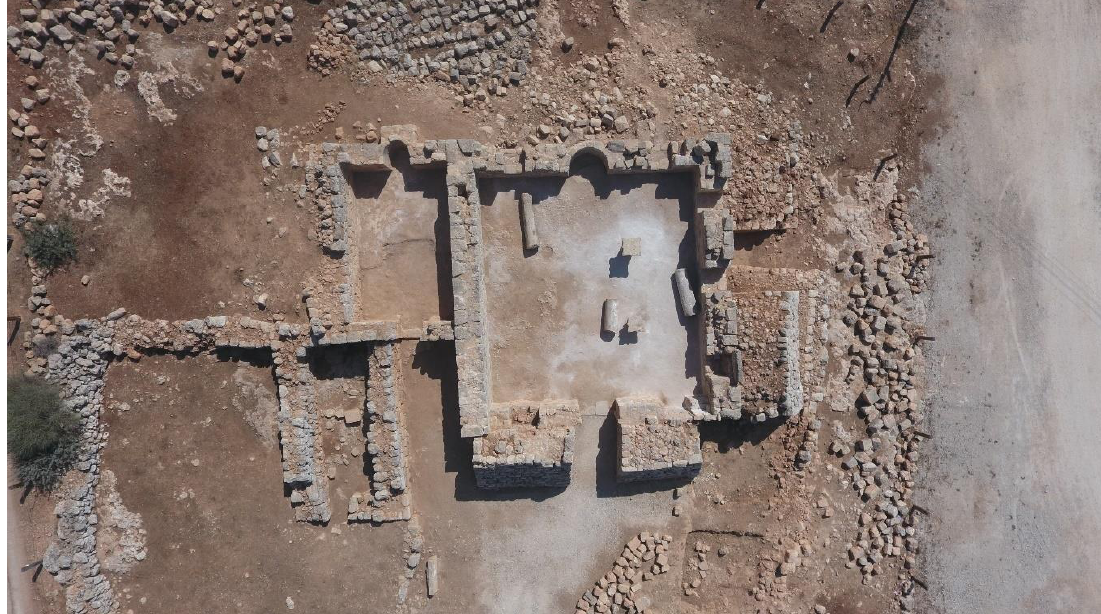
Figure 2. Jami ʿ al-Sitin : South to the top, courtesy of https://www.a-shiloh.co.il/en (accessed on 23 Figure 2. Jami’al-Sitin : South to the top, courtesy of https: // www.a-shiloh.co.il / en (accessed on